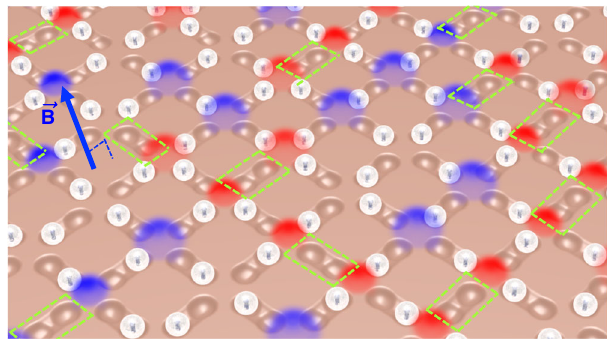
Fig. 1 Schematic of the system. The experimental system consists of paramagnetic colloids placed via optical tweezers in lithographic double wells arranged along the edges of a square lattice. Each colloid is gravitationally trapped in one microgroove, and it can sit in one of the two wells. A perpendicular fi eld B magnetizes the colloids, thus introducing a repulsive dipolar interaction. The edges of the square lattice can be decimated by simply removing the colloids from the corresponding microgrooves (dashed green rectangles). Red and blue glows denote positive and negative topological charges,